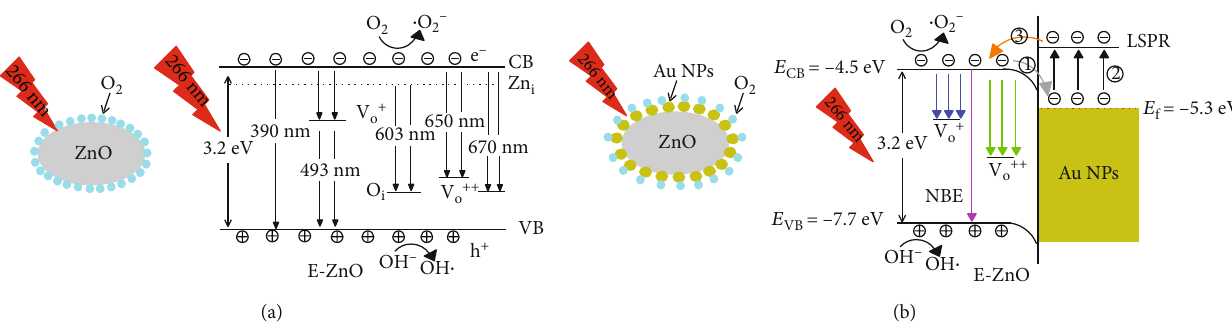
Figure 11: Schematic illustrations of photogenerated carrier transfer and recombination transient process for pristine E-ZnO (a) and Au/E- ZnO nanosystem (b) in ambient condition under 266 nm irradiation,